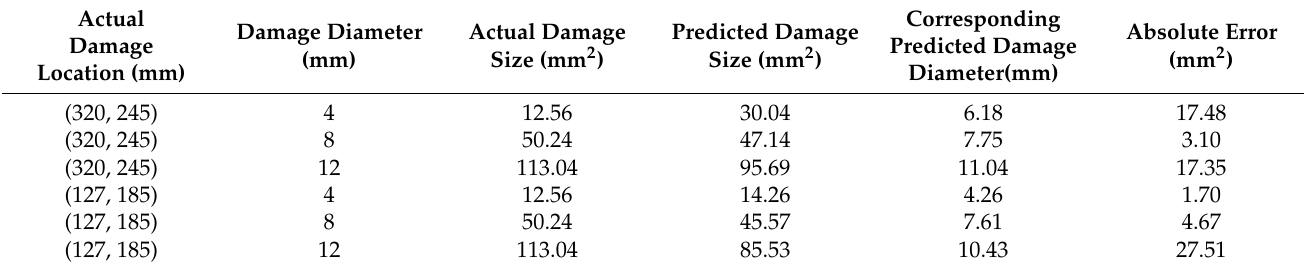
Table 3. Damage quantification prediction results and